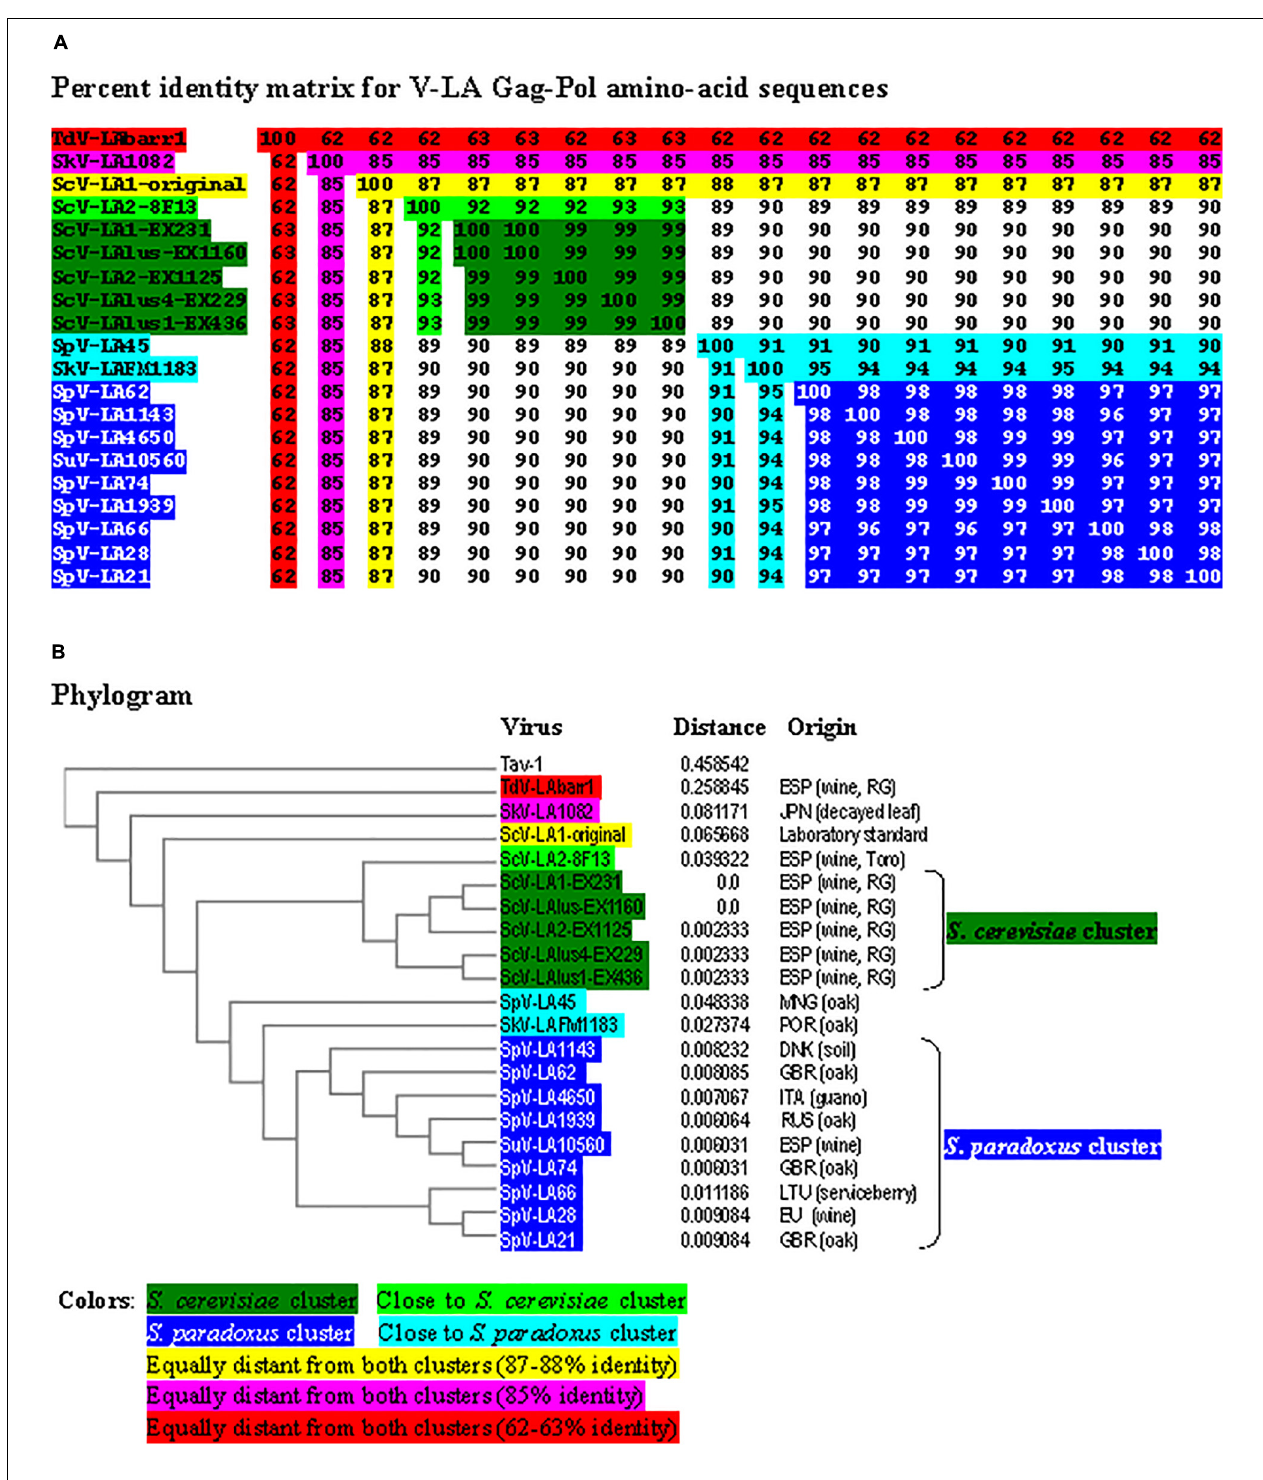
FIGURE 3 | Phylogenetic relationship of yeast LA viruses. (A) Percentage identity matrix between the complete amino acid sequences of the Gag-Pol proteins of LA viruses. Each identity value is rounded to the nearest whole number. (B) Phylogram with evolutionary distances (given by the MUSCLE program) and geographical location at which each killer yeast strain was isolated. RG, Ribera del Guadiana. Country codes are in accordance with the International Organization for Standardization ISO 3166-2. Viruses included in each of the two main clusters, as well as their identity values, are shaded in dark-green or dark-blue. The relative identity with these clusters of the rest of the viruses is indicated by shading in other